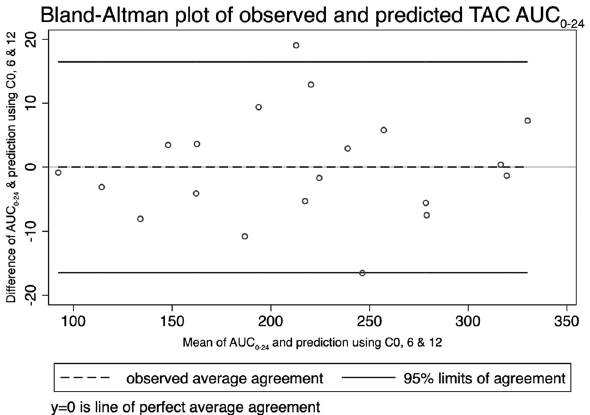
Figure 3. Bland–Altman plot between observed and predicted TAC AUC 0-24 by C0, C6, and C12 equation.